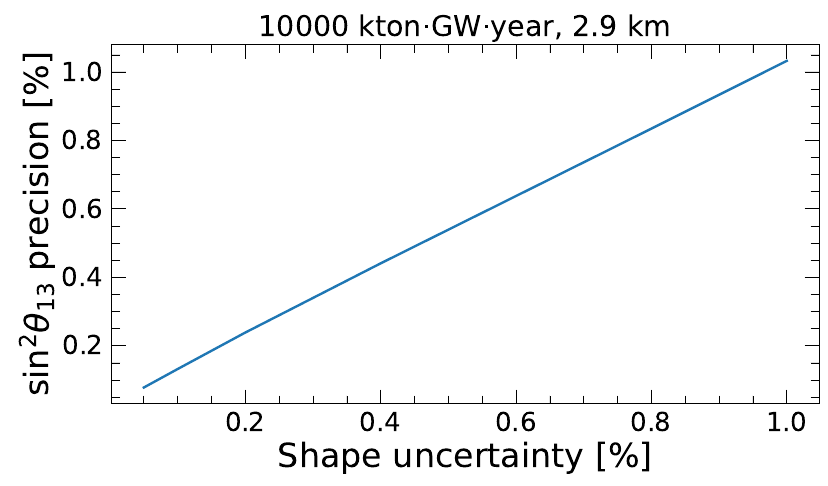
Figure 3 . The sin 2 θ 13 precision sensitivity for different input spectral shape uncertainty. The x-axis is the spectral relative shape uncertainty in %. The baseline is 2.9 km, and the luminosity is 10 4 kton · GW · year . The sin 2 θ 13 precision sensitivity is almost linearly proportional to the spectral shape